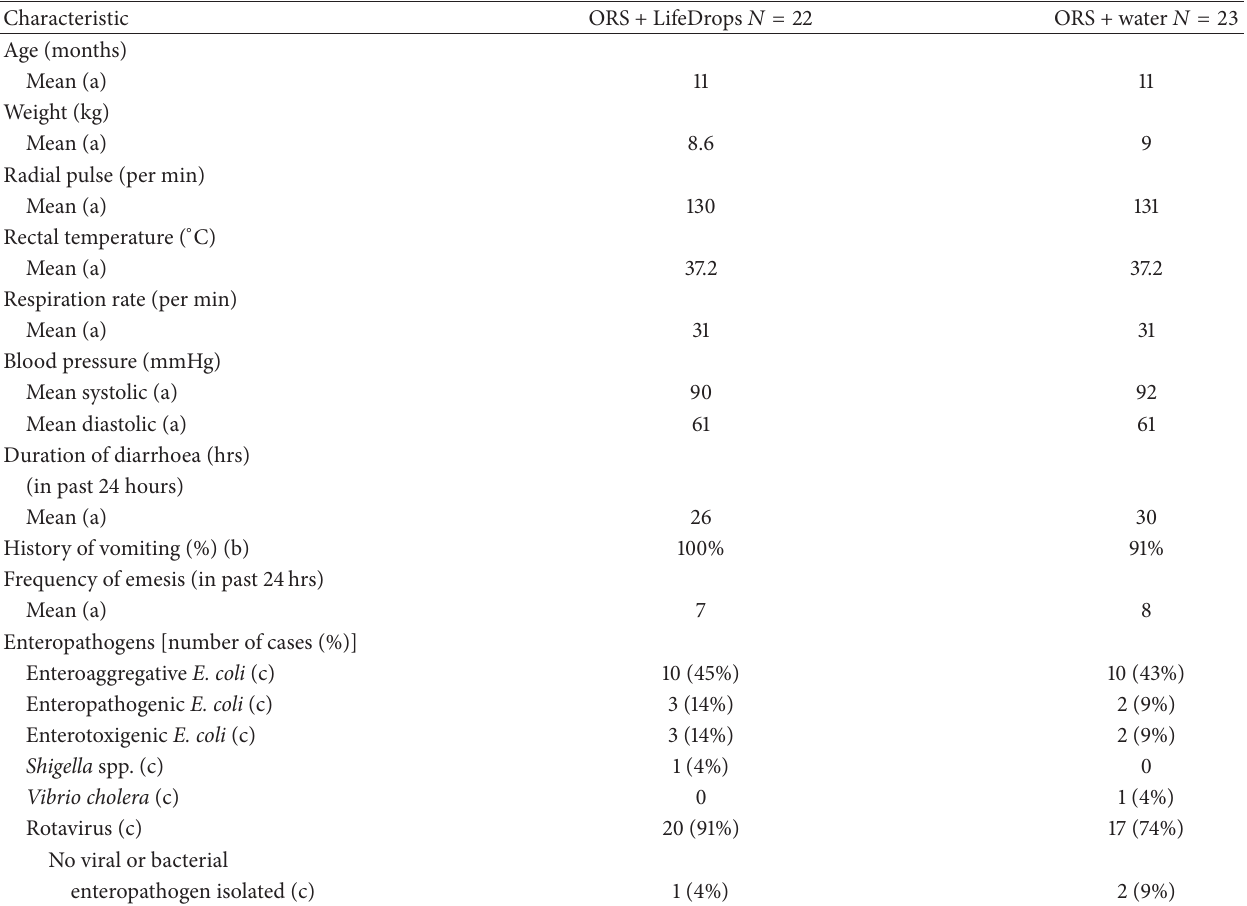
Table 2: Admission characteristics of subjects aged 6 to 23